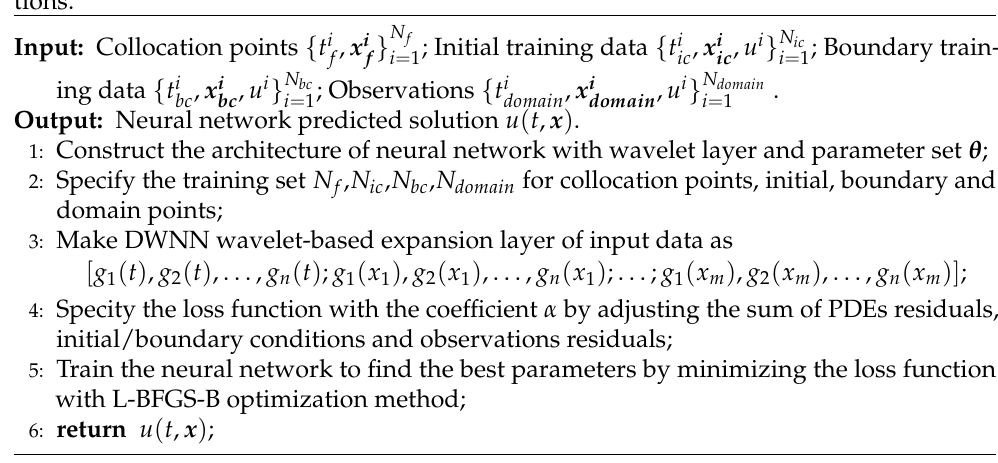
Algorithm 1 Deep Wavelet Neural Network (DWNN) for solving partial differential equa-